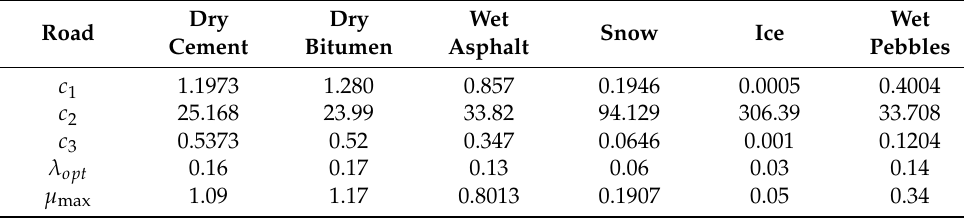
Table 1. Ideal slip ratio and adhesion coefficients of different road surfaces.